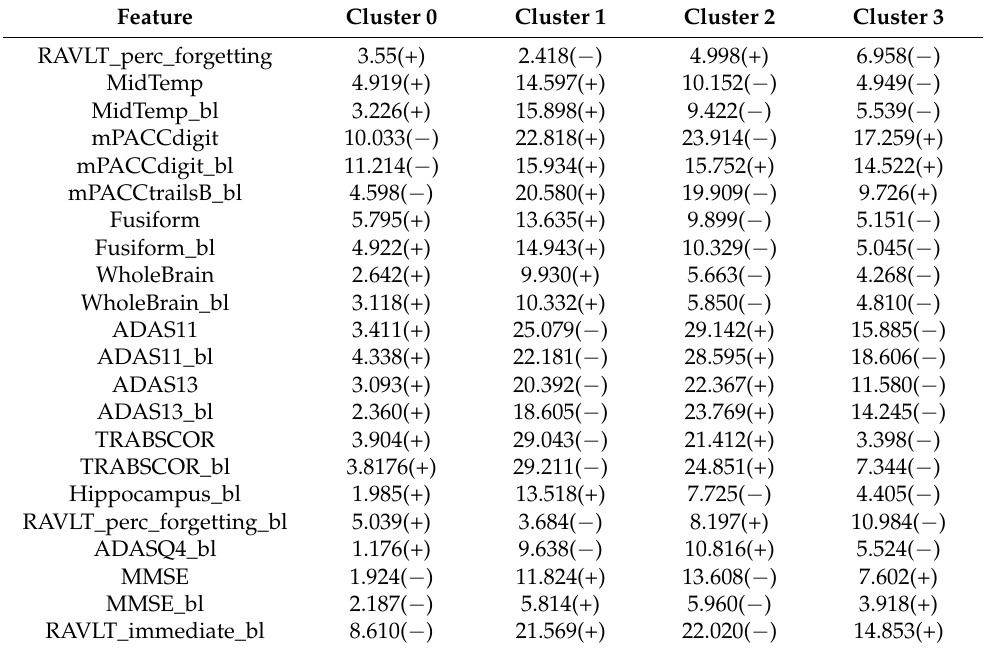
Table 3. Top features for each of the four clusters based on analysis with post-hoc t -test. (+) denotes an increase, and ( − ) denotes decrease in percentage compared to the mean values of the whole dataset. Note that ‘_bl’ corresponds to